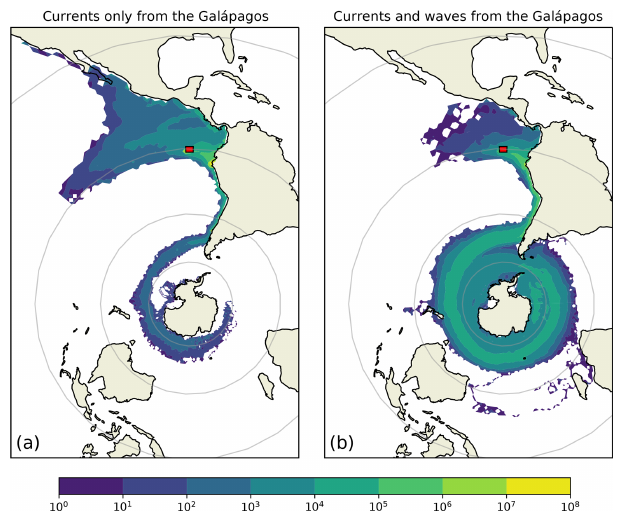
Figure 3. Map of “Origin from Galápagos” scenario, showing the density of particle trajectories that end up in the Galápagos region (red rectangle) for particles carried by currents only (a) and for par- ticles carried by the currents and waves (b) . The scale is the number of particle crossings per 1 ◦ × 1 ◦ grid cell on a logarithmic scale. Grey circles denote the 60 ◦ S and 30 ◦ S, Equator and 30 ◦ N latitude bands. Beaching is not taken into account in this simulation, and the maximum length of the trajectories is 10 years. Most trajecto- ries remain in the eastern tropical Pacific Ocean or originate from the Southern Ocean.